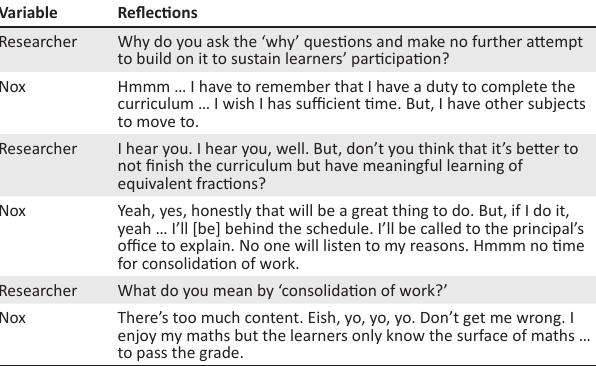
TABLE 4: Nox’s reflections on her